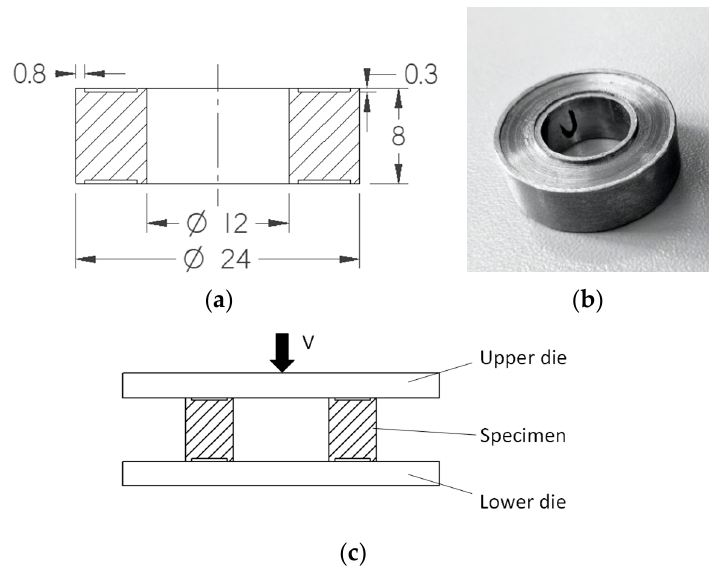
Figure 3. Schematic diagram of the specimens ( a ), a specimen image ( b ), and a schematic diagram of the process ( c ).